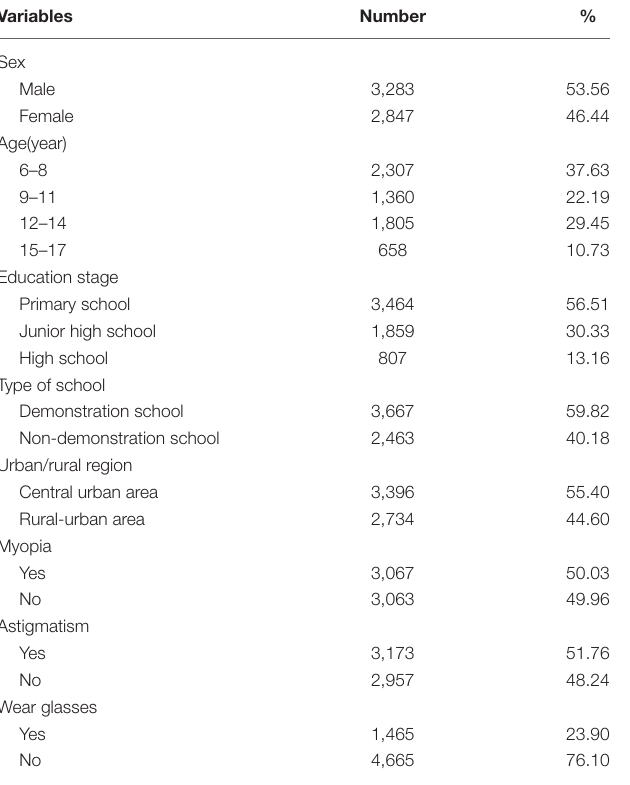
TABLE 1 | Distribution of basic demographic characteristics of